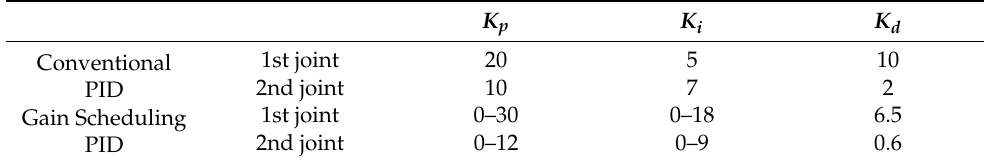
Table 7. Gain table for the conventional PID and the Gain Scheduling PID tuned. K p K i K